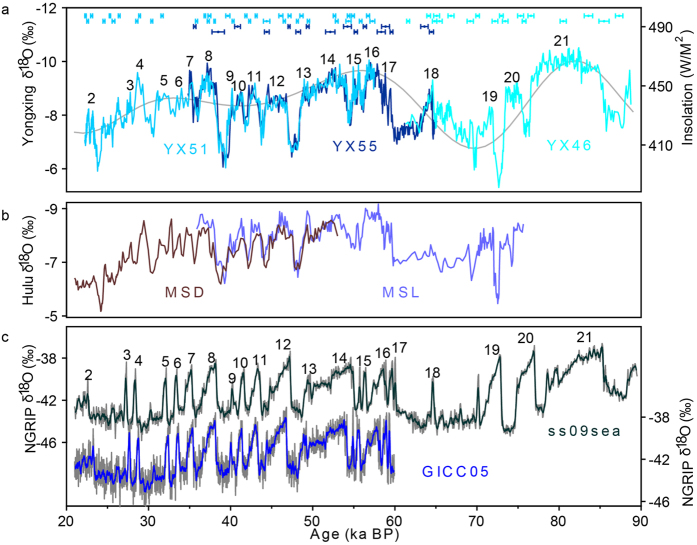
Comparison of the cave and Greenland records.(a)
δ18O records from Yongxing Cave stalagmites (YX51, sky blue; YX55, navy blue; YX46, cyan), and the summer (21 July) insolation at 65°N (grey). 230Th ages and 2σ errors shown at the top are color-coded as for stalagmites. (b)
δ18O records from Hulu Cave stalagmites14 (MSD, dark brown; MSL, electric blue). (c)
δ18O records from Greenland NGRIP ice core15 on ss09sea timescale17 (black) and GICC05 timescale16 (blue), respectively. Numbers refer to DO events.